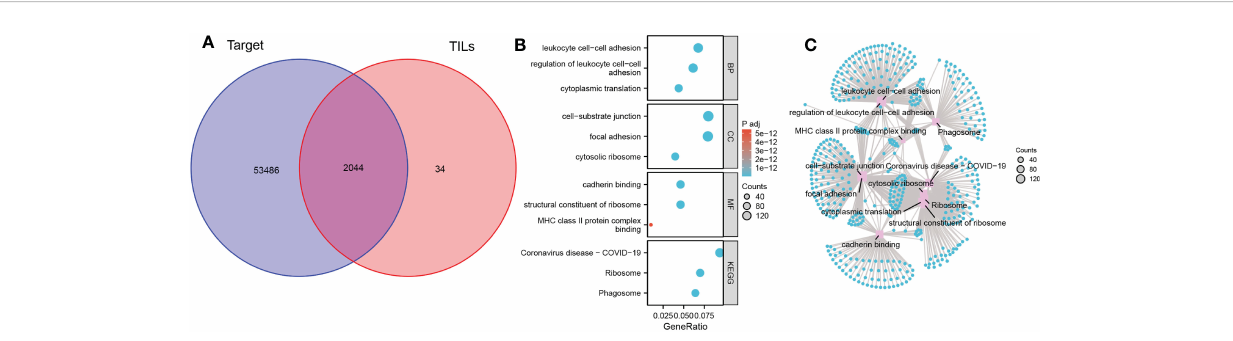
FIGURE 2 Biological functions and pathways of TILs marker genes. (A) Venn diagram of 2044 TILs marker genes from TARGET OS cohort and scRNA-seq data. (B) Bubble plot of the functions and pathways of TILs marker genes. (C) Network plot of the functions and pathways of TILs marker